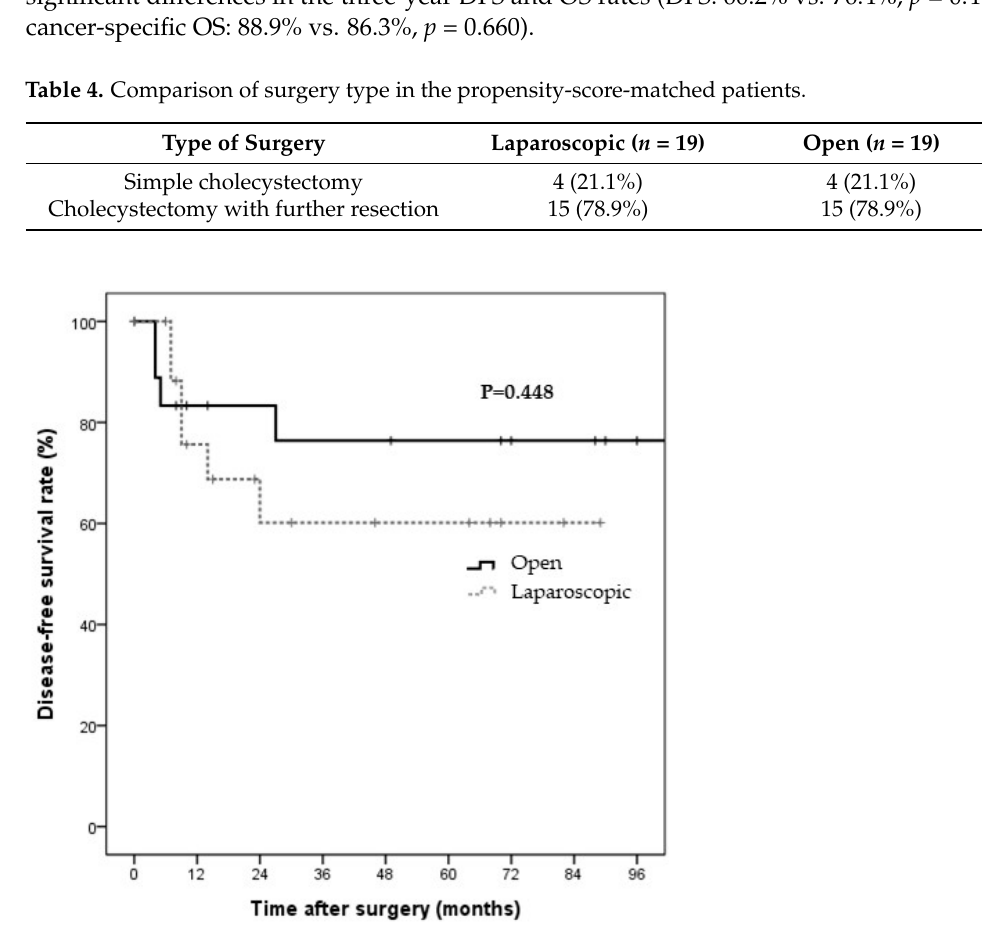
Figure 4. The cancer-specific survival rate in the propensity-score-matched patients by surgery type. The cancer-specific survival rates in the propensity-score-matched patients at three years were 88.9% and 86.3% in the laparoscopic and open surgery groups, respectively. No significant differ- ences were observed between the laparoscopic and open surgery groups ( p = 0.660) in terms of sur- vival.